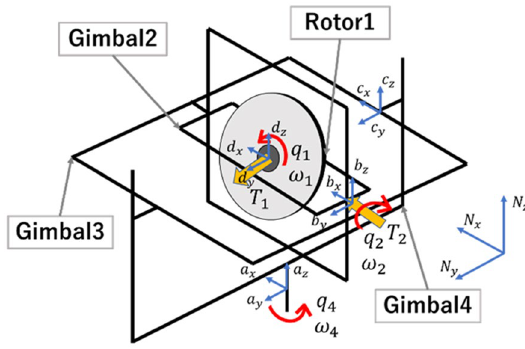
Figure 1. Structure of the CMG